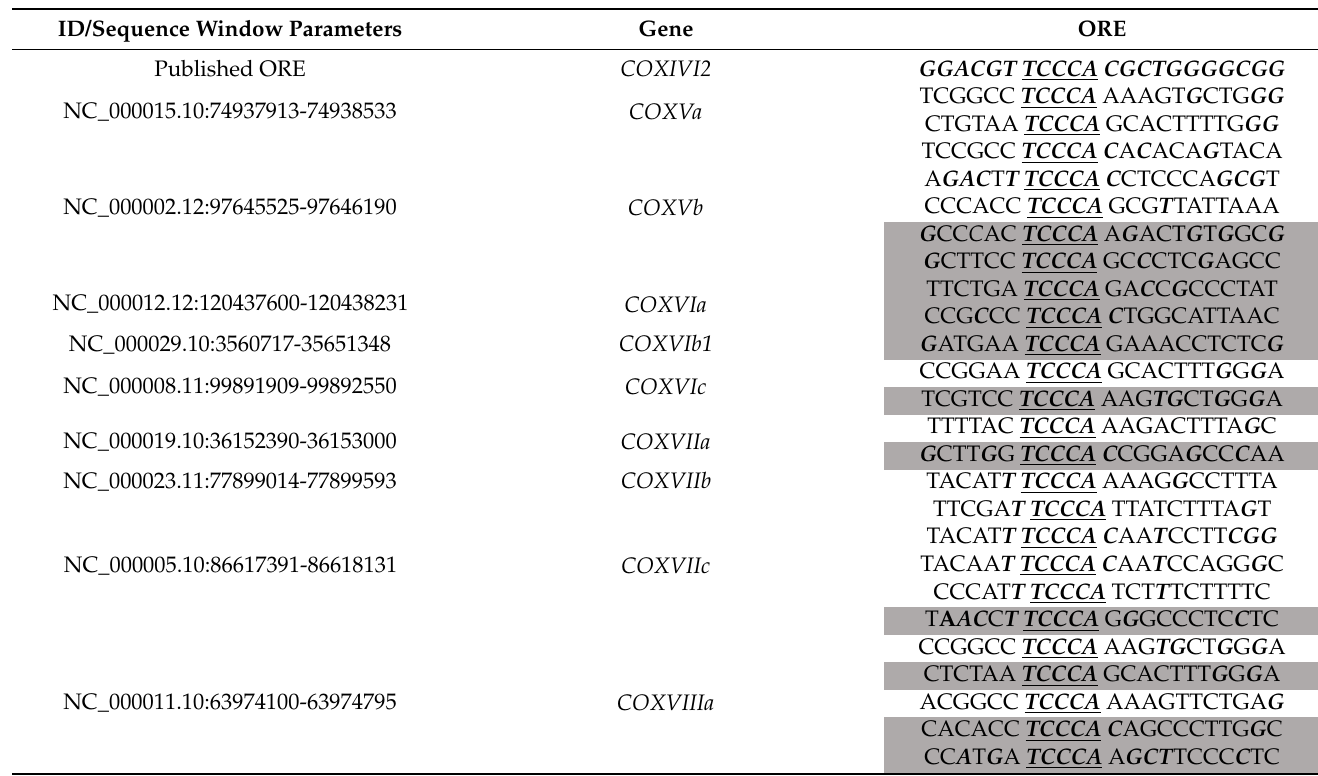
Table 4. COX subunit and assembly genes containing oxygen responsive element (ORE) within 500 bp of transcription start site. TCCCA is the minimal ORE element required for R1 mediated transcription. Bold and italicized bases match the classical ORE motif found in the promoter of COX4I2 . Shaded sequences represent the non-coding strand. ID/Sequence Window Parameters Gene ORE Published